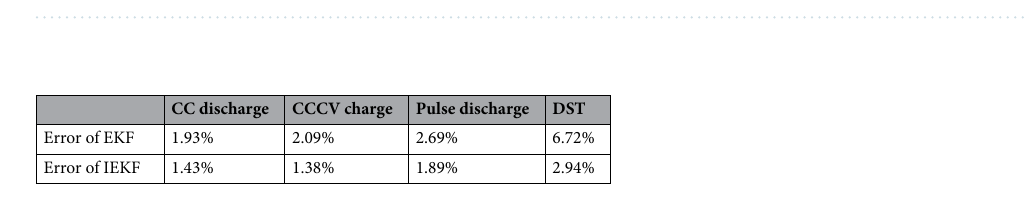
Table 6. Tested battery characteristics.